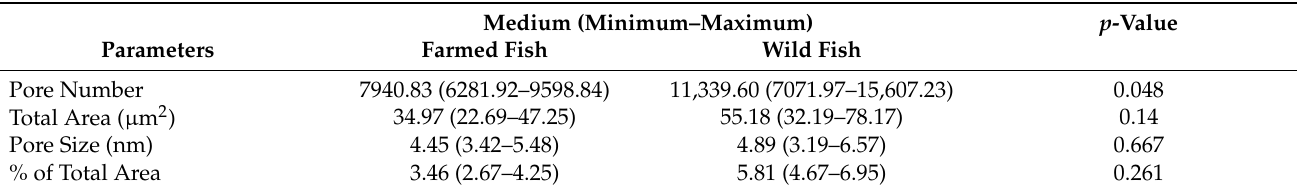
10 of 15 Figure 8. 3D projection in rainbow trout ( Oncorhynchus mykiss ) jawbone microstructure. ( a ) Farmed